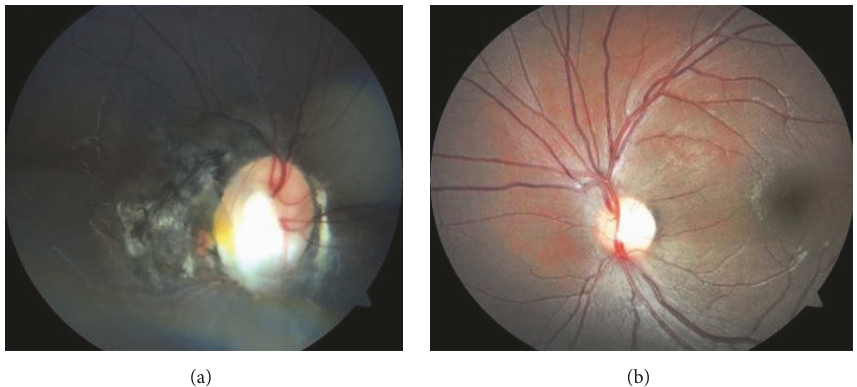
Figure 1: Large anomalous optic disc with conical excavation, significant peripapillary pigmentation, and some straightening of the retinal vessels arising from the disc margin of the right eye (a); normal appearing fundus of the left eye